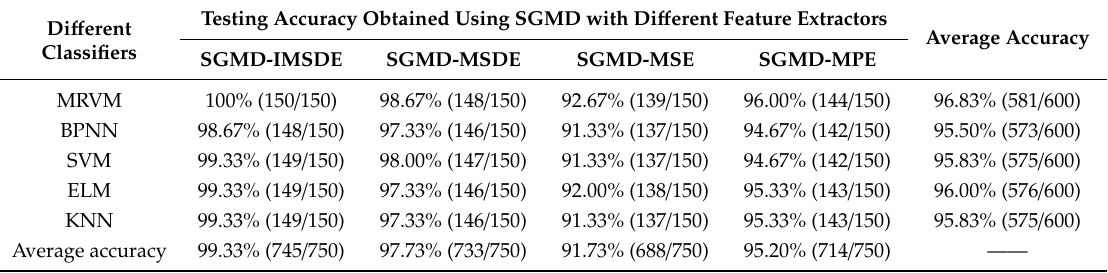
Table 8. Diagnosis results of combining various classifiers with SGMD containing di ff erent feature